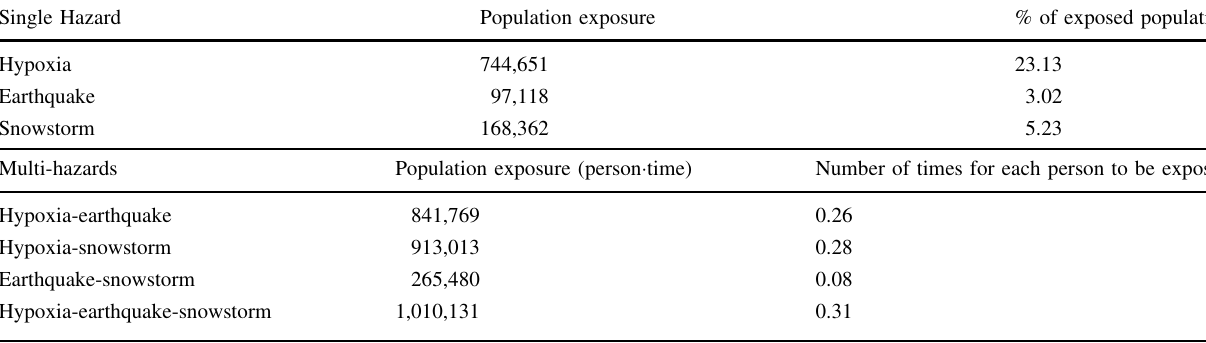
Table 6 Population exposure to single hazards and multi-hazards in Tibet, 2015 Single